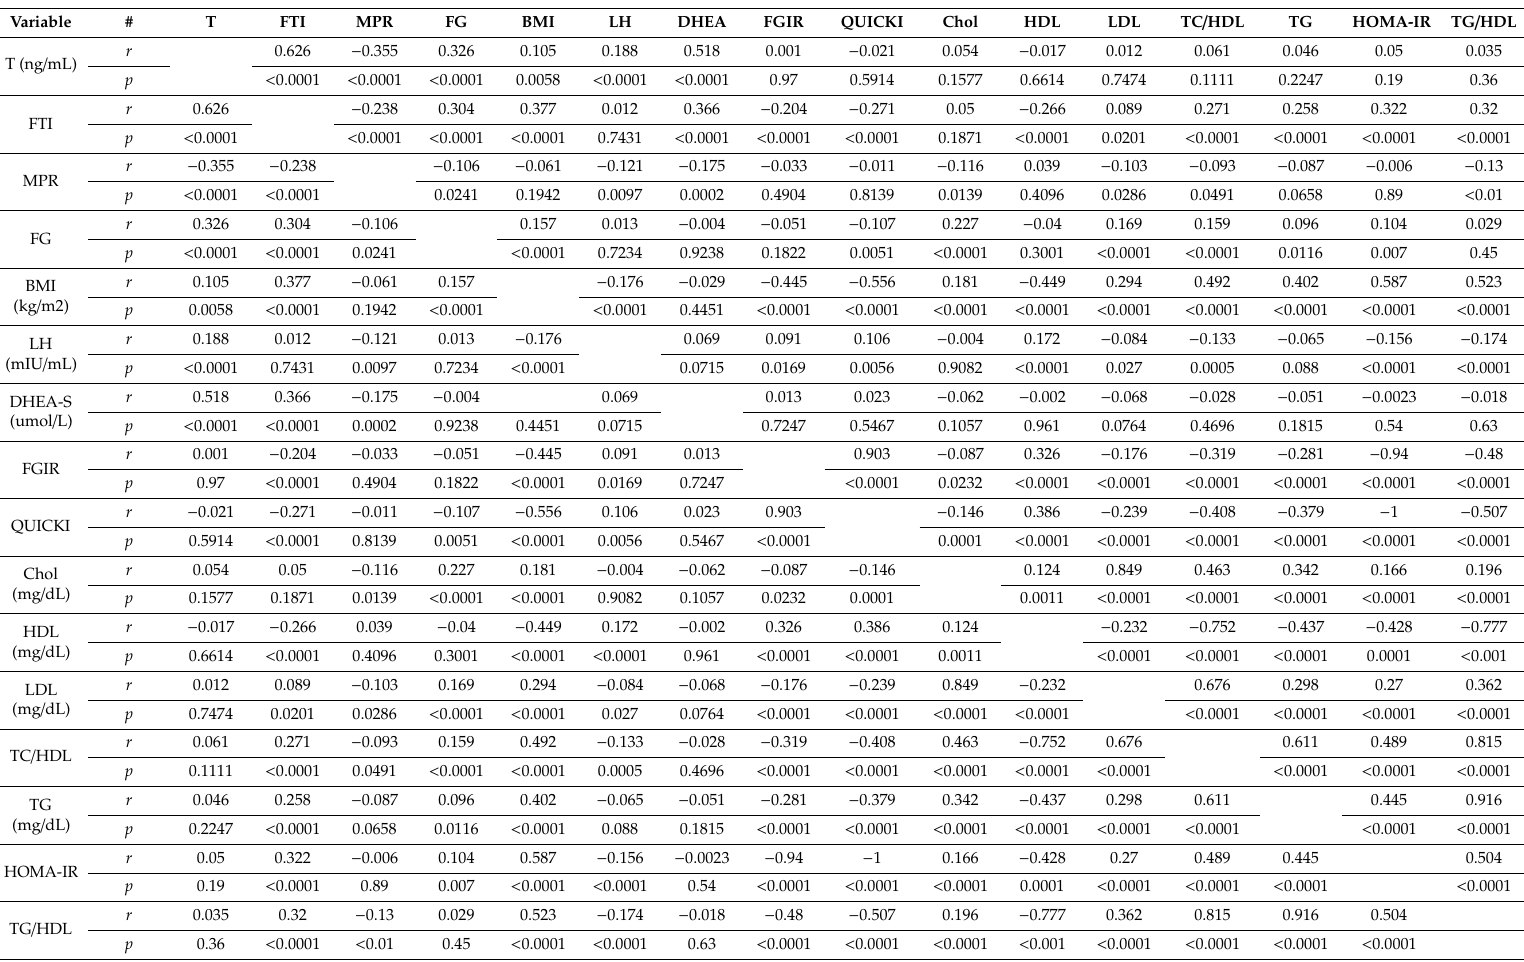
Table 3. Correlation between studied parameters in the whole polycystic ovary syndrome (PCOS)